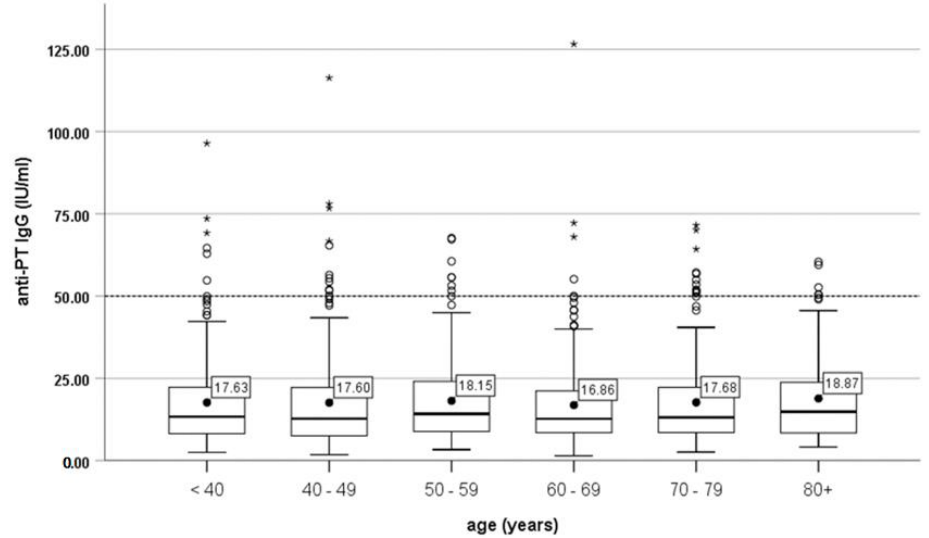
Figure 2. Pertussis anti-PT IgG (mean) by age. Anti-PT IgG (mean titers) ranged between regions from 25.18 IU/mL of region of Pel- oponnese followed by the region of Thessaly with 23.37 IU/mL, and the lowest proportion was recorded by the region of Central Macedonia with 14.22 IU/mL, anti-PT IgG (Figure 3).